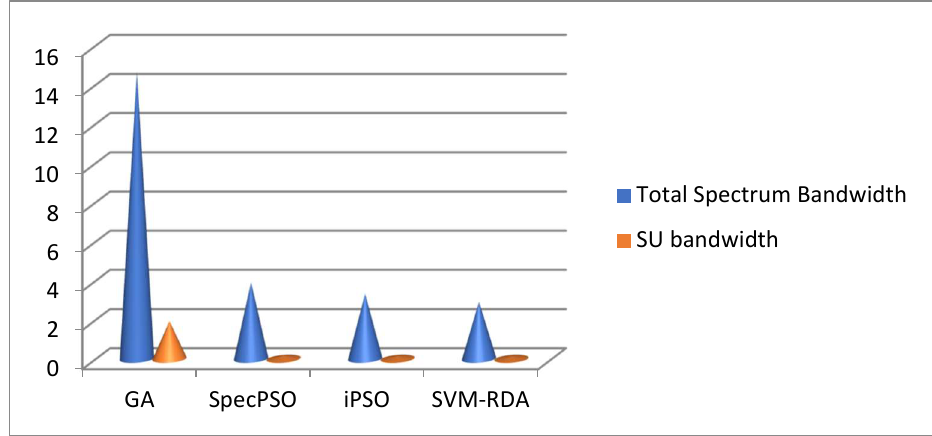
Figure 4. Frequency allocation for SU.